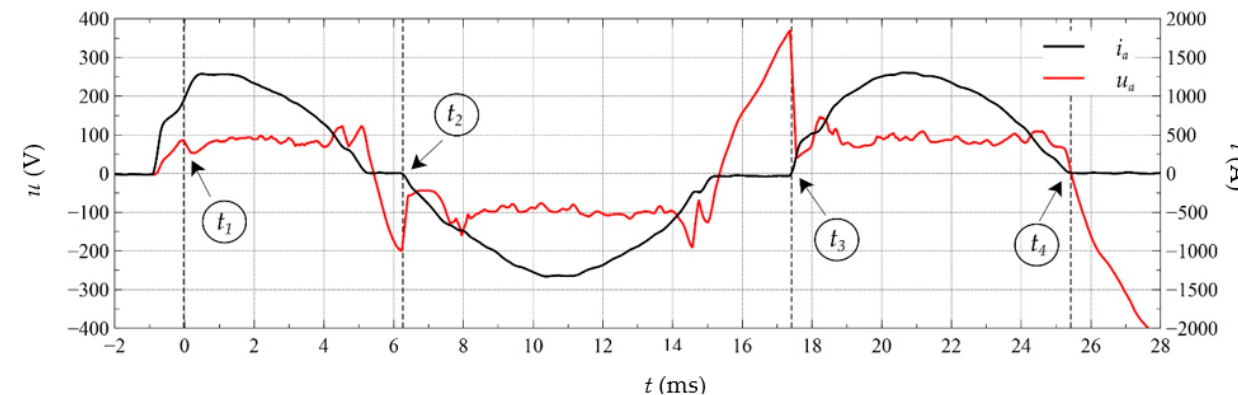
Figure 8. The waveform of the arc current i a (t) and the arc voltage u a (t) for three half-waves of the arc disturbance).